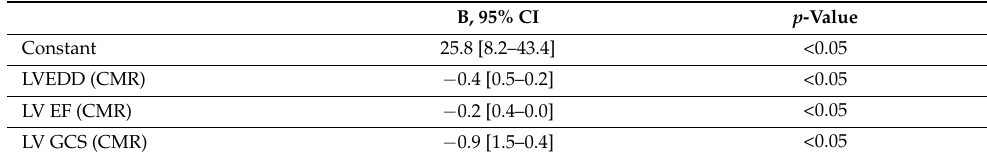
Table 5. Linear regression model when the independent variable is reversibility score (CMR 4 score vs. PET 3/2/1/0 score) and coefficient of determination (R 2 ) is 0.72.